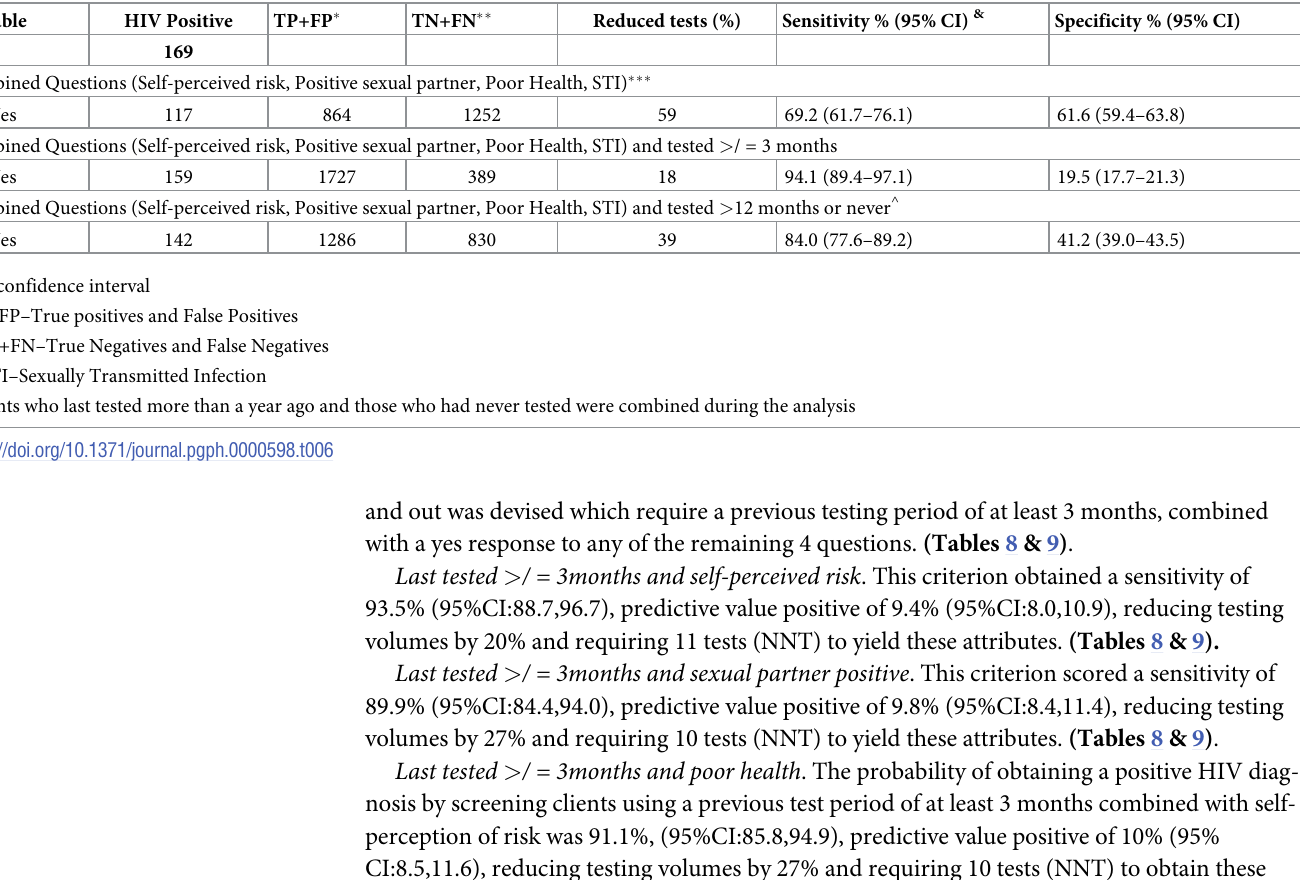
Table 6. Sensitivity and specificity for combined HIV testing services screening questions, Zimbabwe, 2021. (N = 2116). Variable